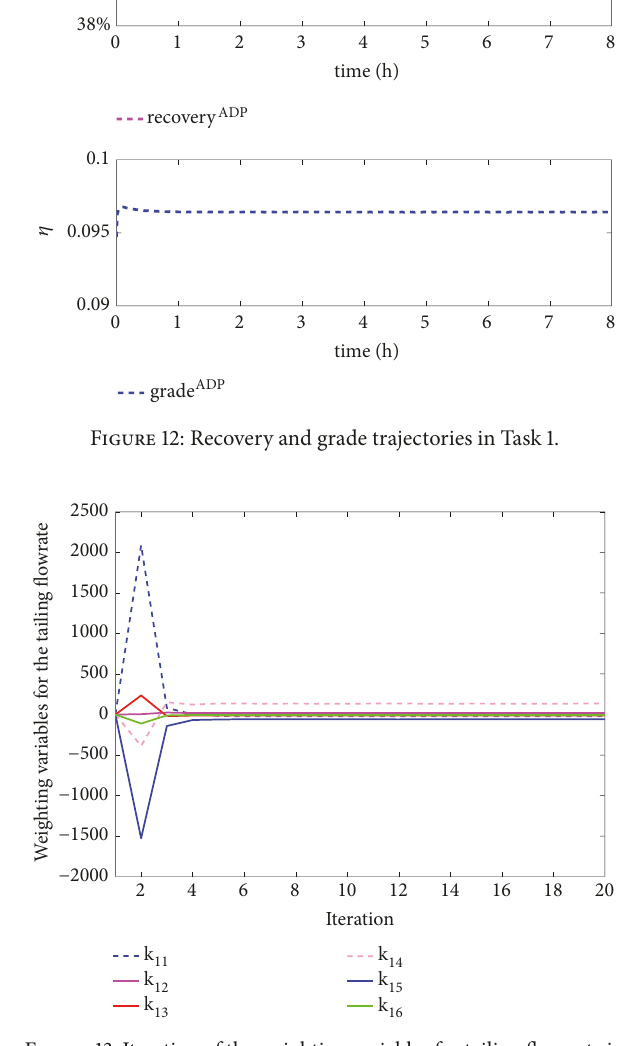
Figure 13: Iteration of the weighting variables for tailing flow rate in Task